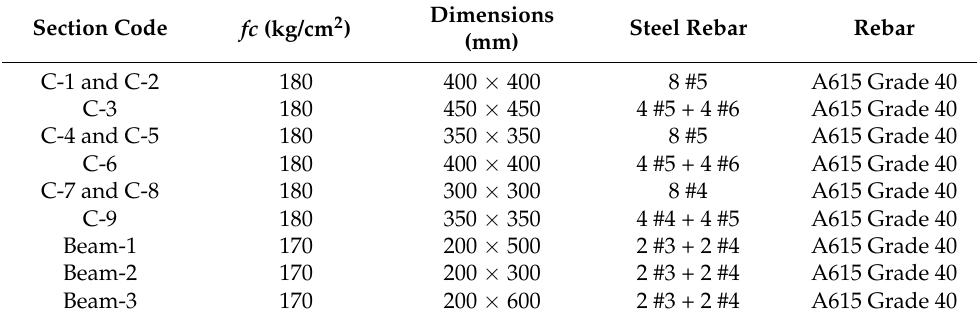
Figure 7. Distribution and geometry of the beams and columns. Table 2. Geometry of the sections and specifications of the materials of the beams and columns of the building studied.